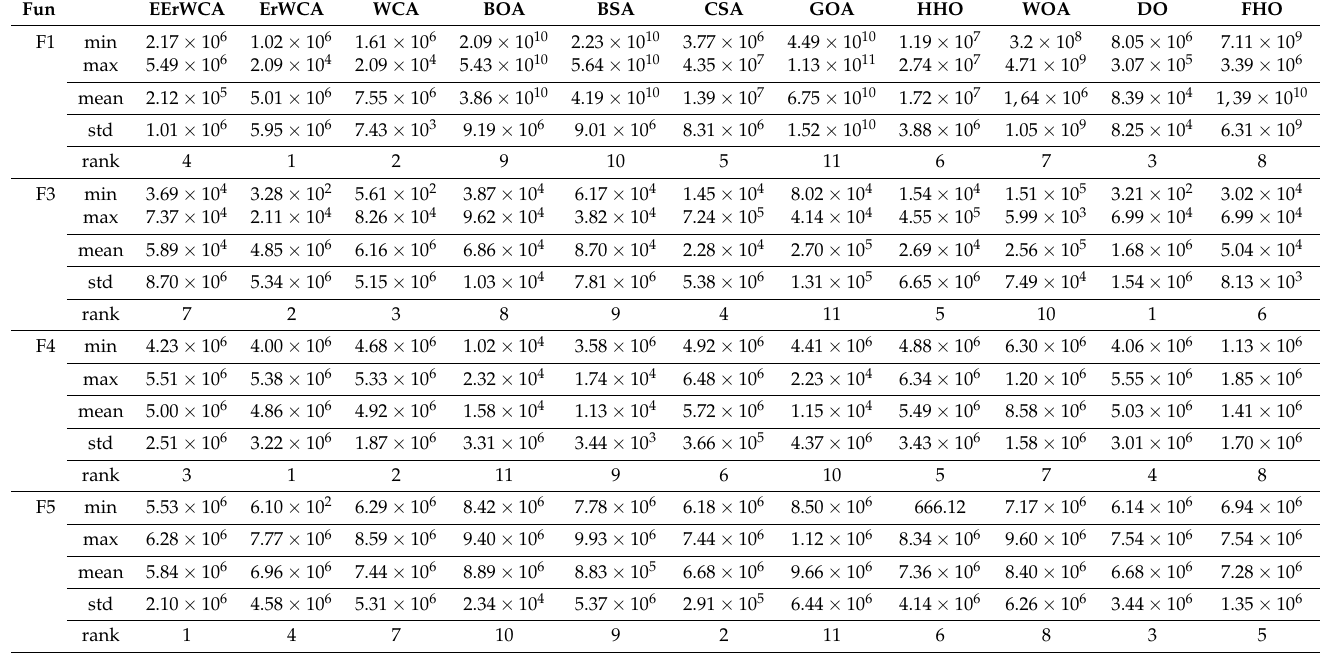
Table 3. The comparison results of all algorithms over 29 functions using Dim = 30 CEC